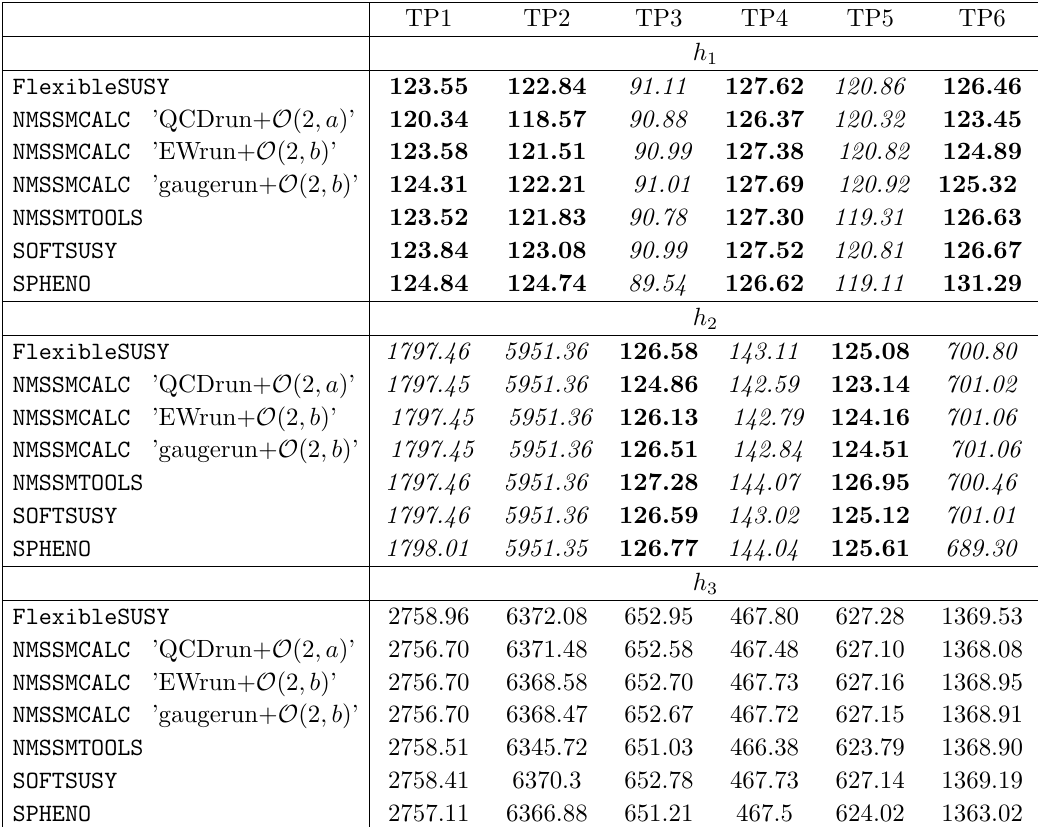
Table 6 . Table adapted from table 3 of [81] with the masses for the CP-even scalars (in GeV) for TP1{TP6 (de(cid:12)ned in table 2 of [81]) when using the spectrum generators \out-of-the-box". The values correspond to the two-loop results obtained by the di(cid:11)erent tools (the NMSSMTools value corresponds to one using the option leading to the most precise calculation implemented in NMSSMTools ). For NMSSMCALC the DR scheme in the top/stop sector is applied in three di(cid:11)erent variants as de(cid:12)ned in the text. The masses for the SM-like scalar are written in bold fonts, those for the singlet-like scalar in